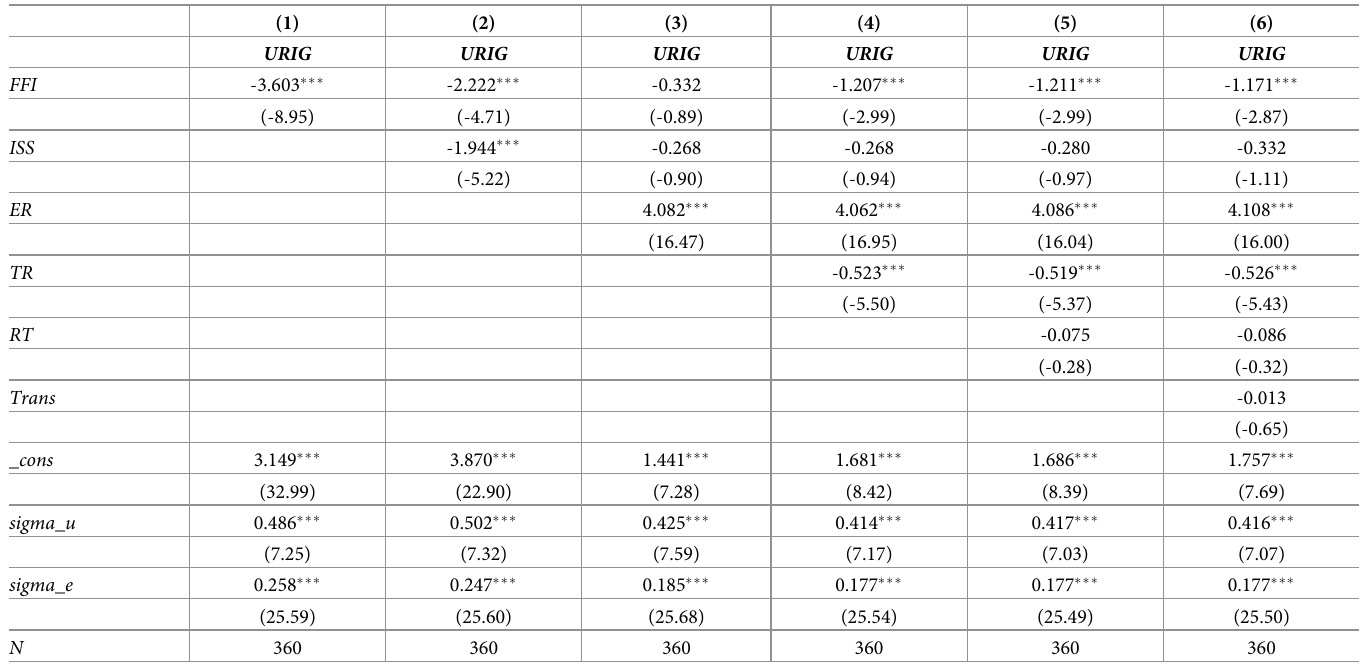
Table 9. Robustness test: Alternative metrology